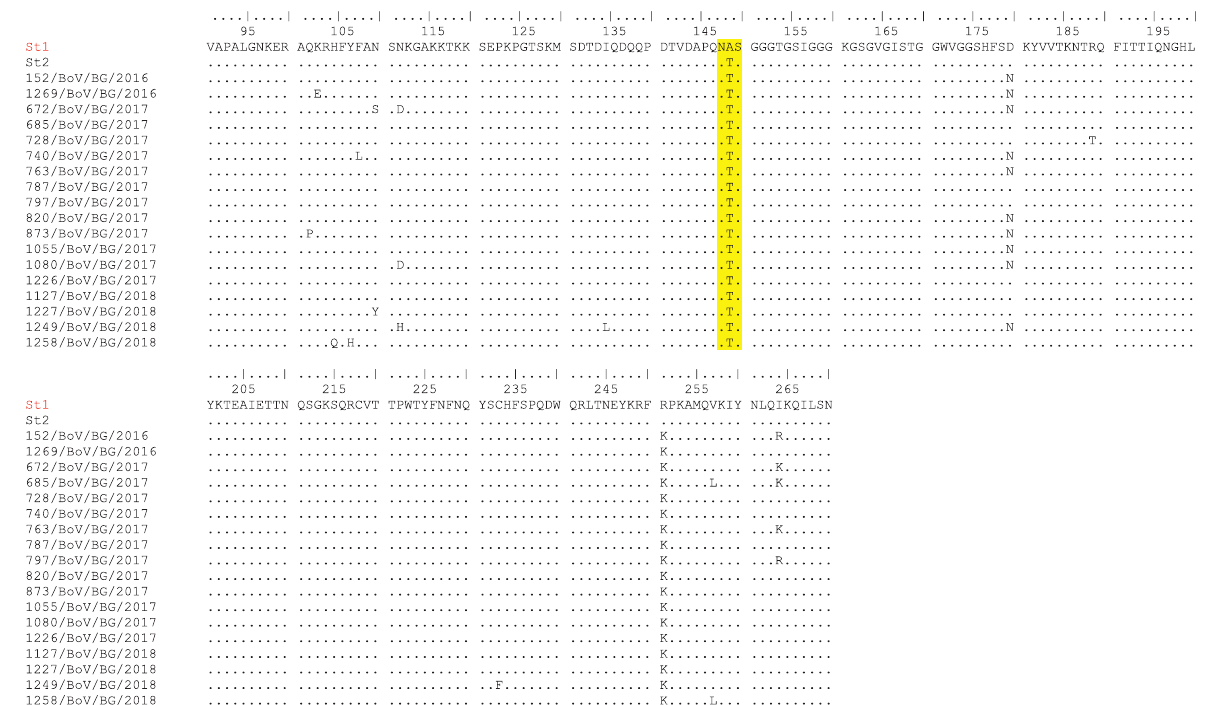
Figure 5: Partial amino acid sequences of the VP1/VP2 protein from Bulgarian hBoV strains. The alignment is shown relative to the sequence of the prototype St1 strain. Identical residues are identified as dots. Yellow shading highlights the predicted N-glycosylation